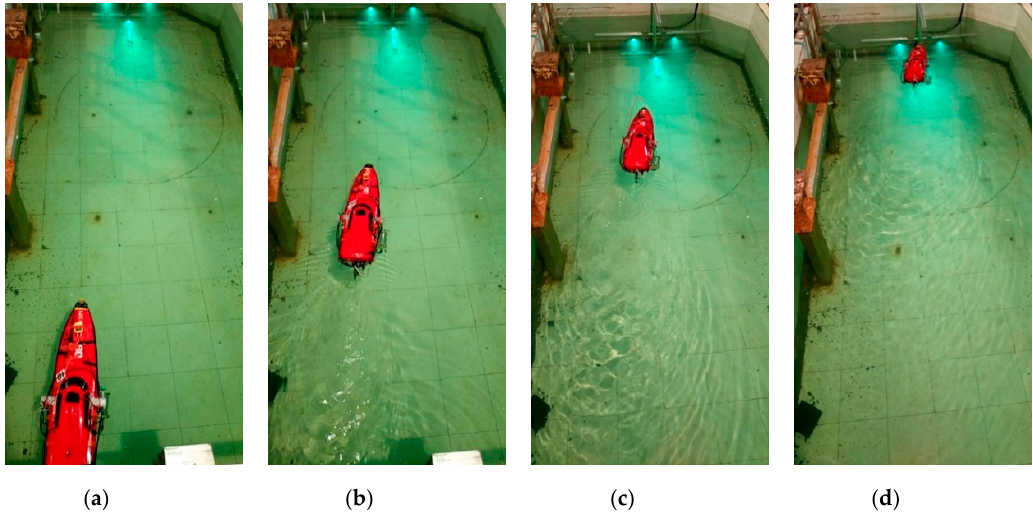
Figure 19. Several photographs acquired during the docking process when the ship model starts at the left side of the docking station: The ship model ( a ) sets off from the initial position on the left; ( b ) turns right to the target; ( c ) moves towards it; ( d ) achieves the docking station successfully.